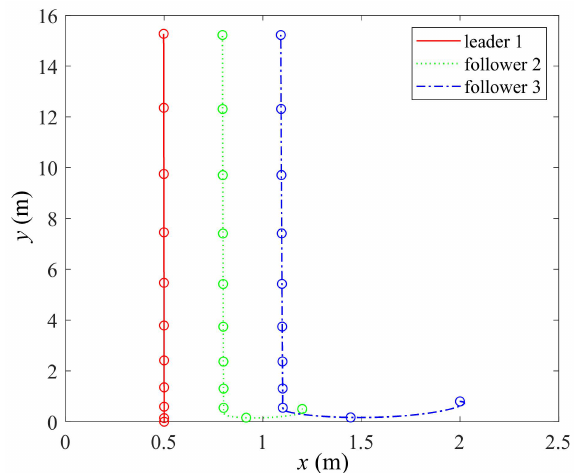
Figure 10. String formation of the platform when moving along a straight